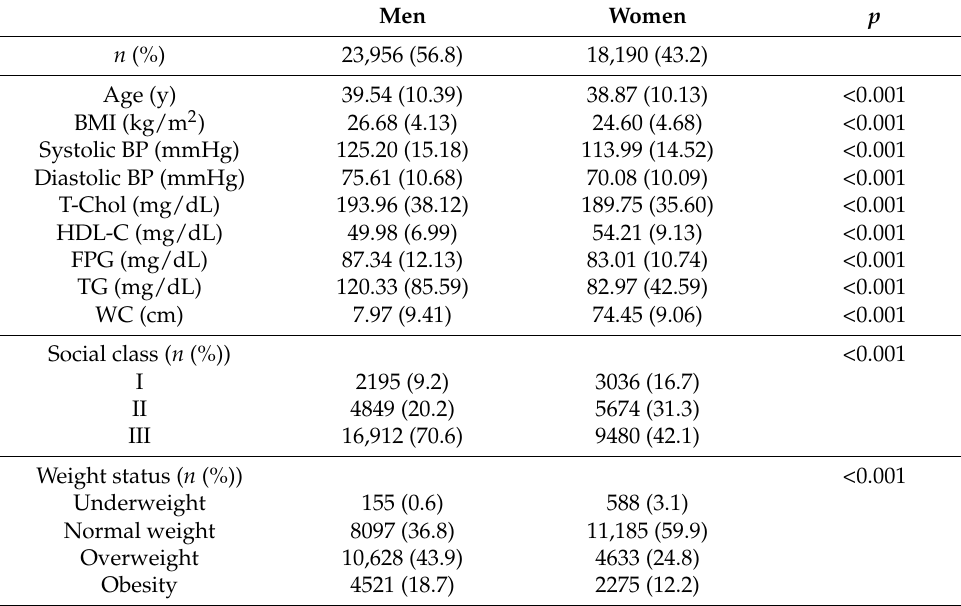
Table 1. General characteristics of study sample stratified by